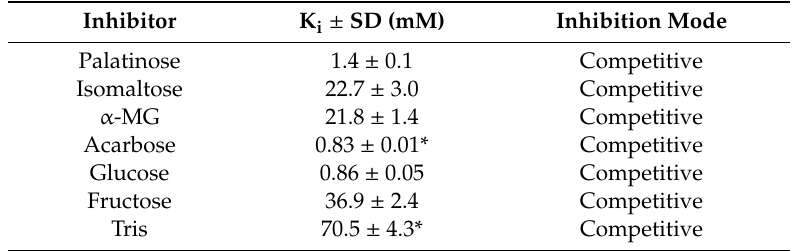
Table 2. K i values and inhibition mode for Ba AG2 inhibitors of p NPG hydrolysis.